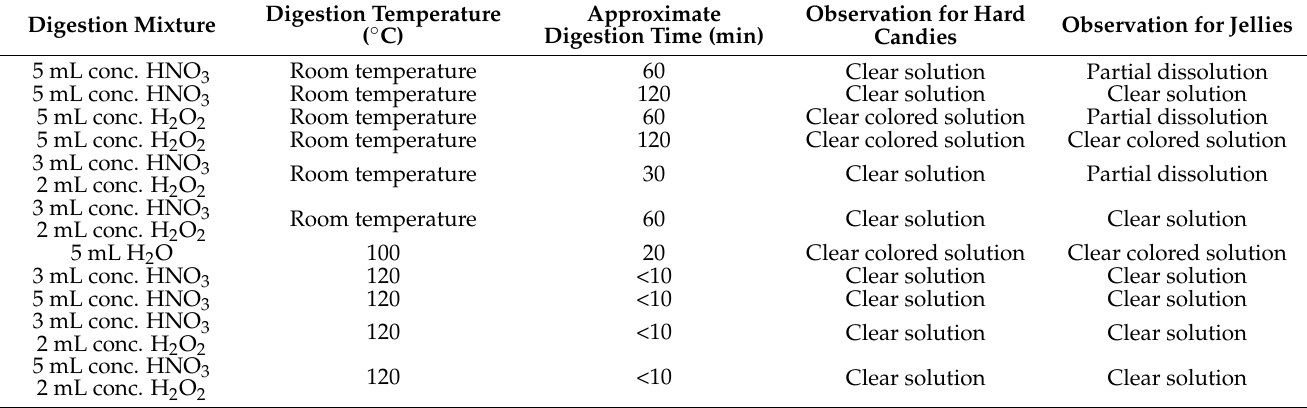
Table 2. Dissolution tests for the digestion of hard candies and jellies (0.5 g